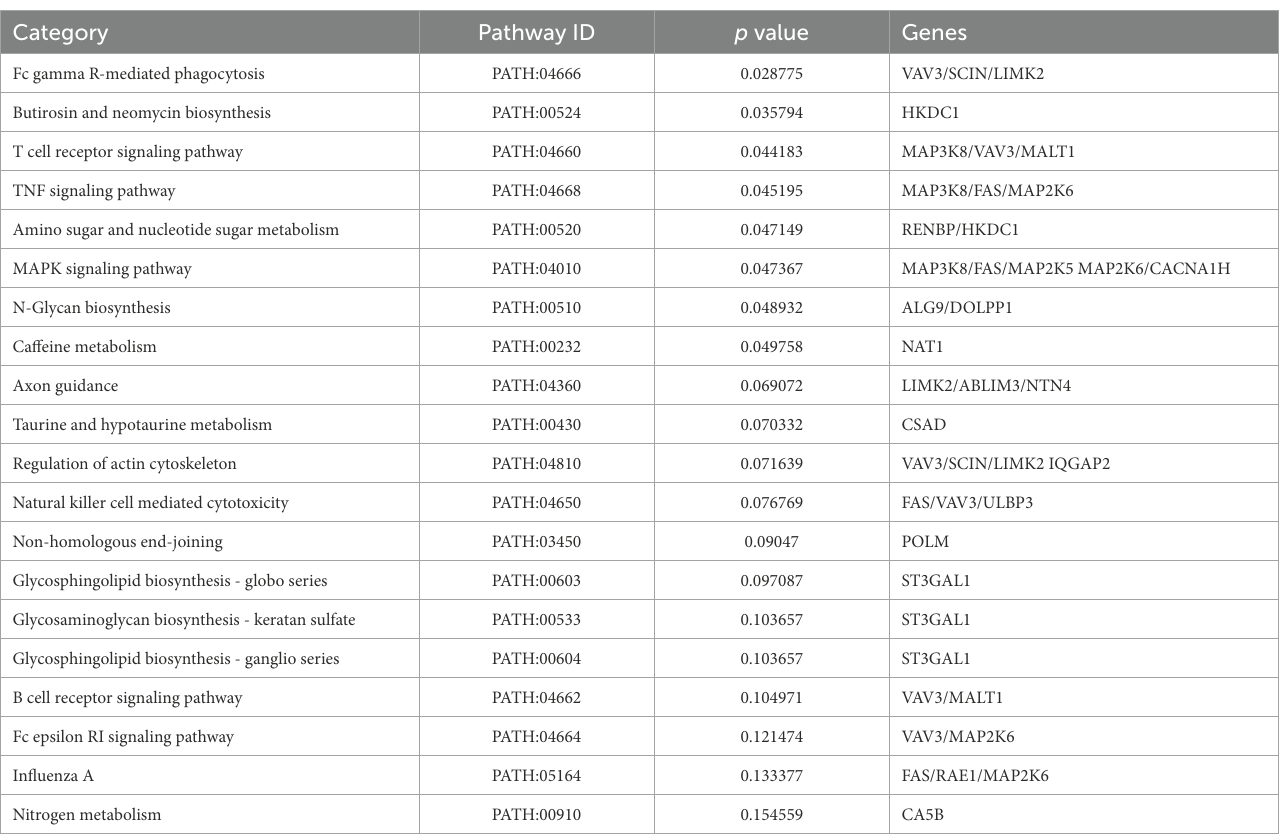
TABLE 4 Top 20 significant enriched pathways of the overlapped DEGs in